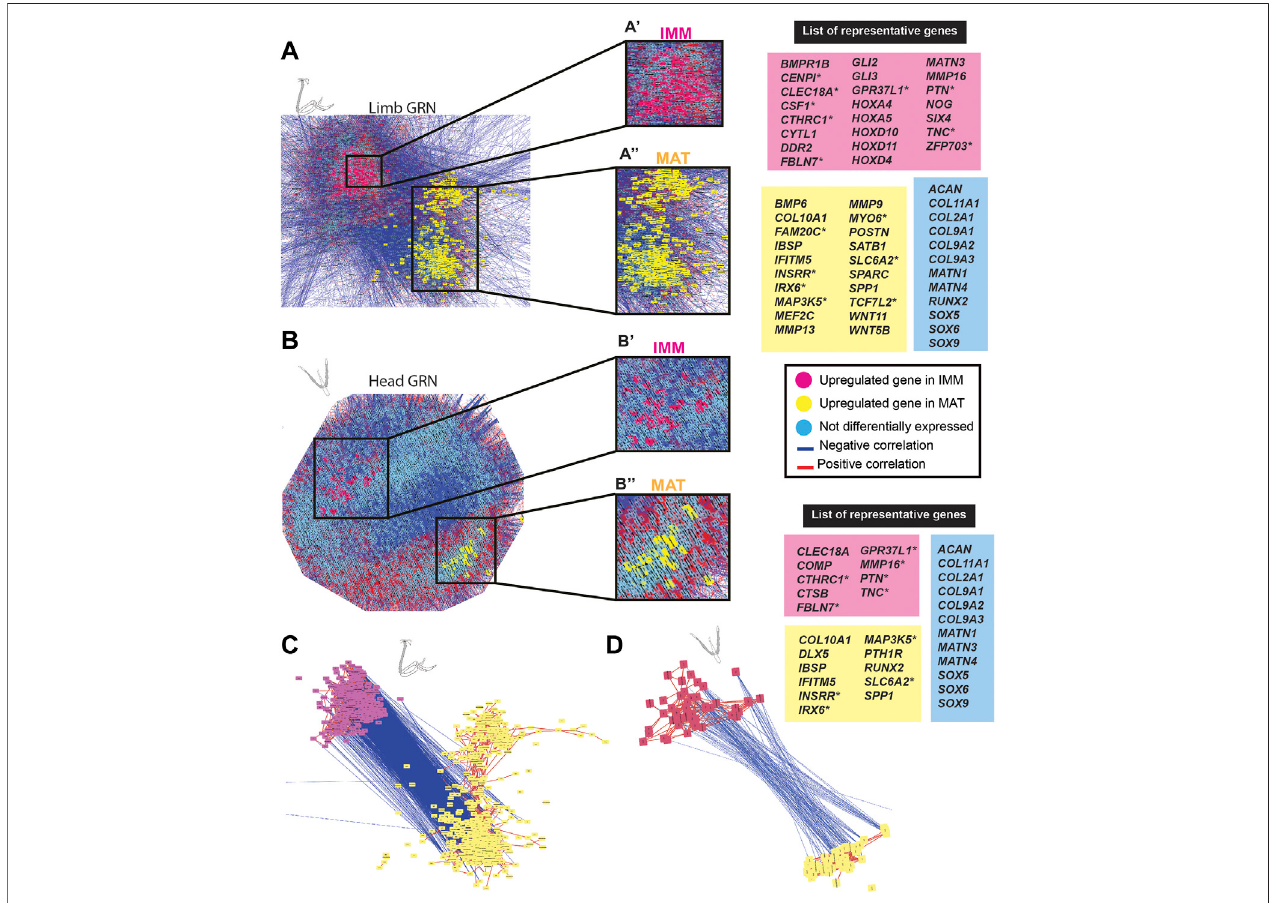
FIGURE3| GCNofeitherlimborheadchondrocytedatawasorganizedintogroupsofenrichedIMMorMATgenesthatwerenegativelycorrelatedwitheachother. (A,B) A GRN underlying chondrocyte differentiation was estimated from a gene co-expression network (GCN) from limb (A) or head (B) chondrocytes (separately normalized). In both limb and head GRNs, one portion contained genes upregulated in IMM (pink nodes), while another portion contained genes upregulated in MAT (yellow nodes). Typical chondrocyte differentiation genes included in the network (light blue nodes) were not differentially expressed between IMM and MAT. RepresentativelistsofgenesineachofthesethreecategoriesareshowntothesideoftheGRNs.Thesecandidategeneswereselectedbecausetheyareknowntohave a role during cartilage differentiation in different vertebrates, and they are listed in alphabetical order. Putative novel genes are indicated by an asterisk next to the gene name. (C,D) IsolatedportionsofIMM-andMAT-enrichedgenesfromthelimb (C) orhead (D) GRNs.MostupregulatedgenesinIMMorMATwereconnectedbypositive interactions (red lines), whereas IMM and MAT genes were mostly connected by negative interactions (blue lines).